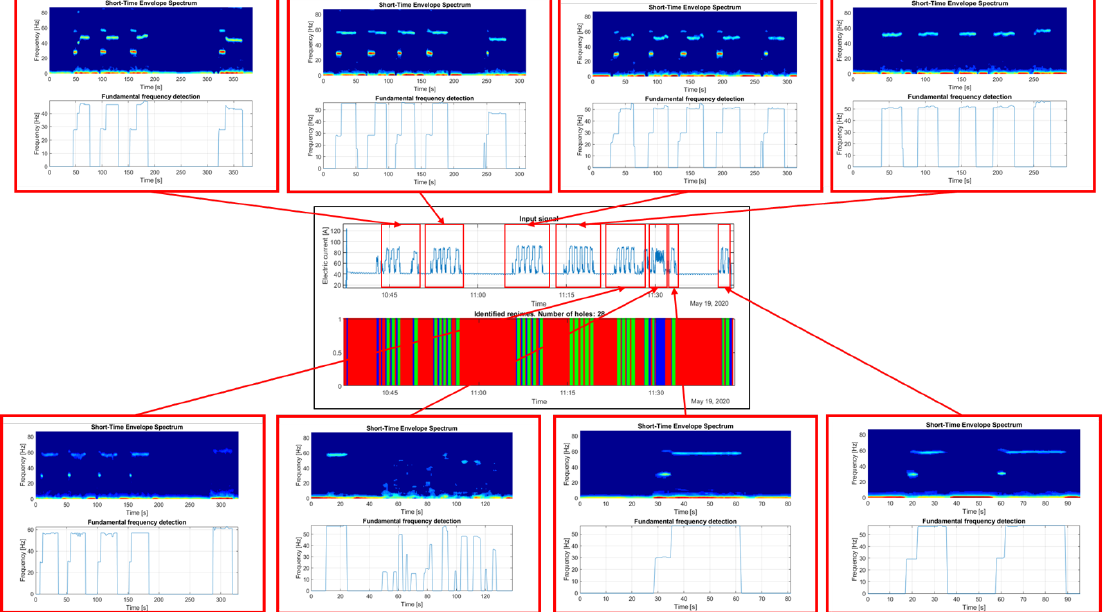
Figure 14. Results obtained for all of the sections of the